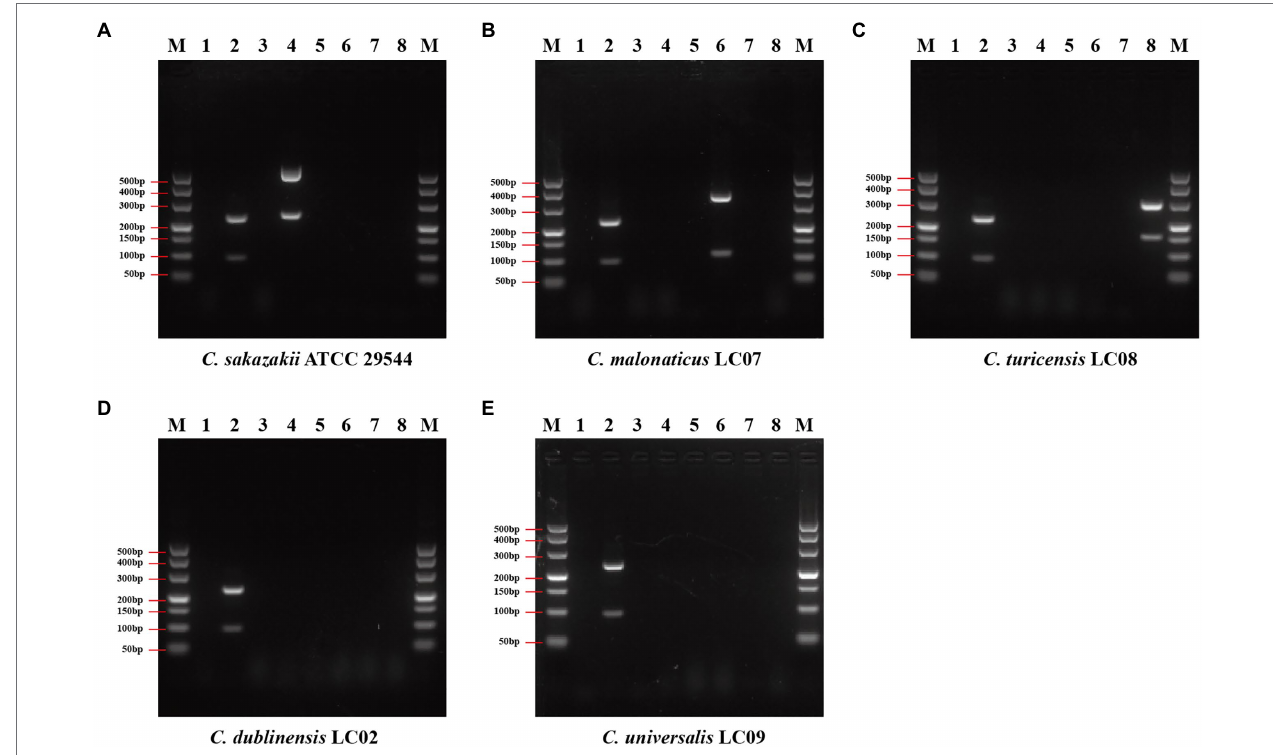
FIGURE 4 | Results of duplex PCR based on genus- and species-specific genes. (A) Cronobacter sakazakii ATCC 29544 ™ , (B) Cronobacter malonaticus LC07, (C) C. turicensis LC08, (D) C. dubliniensis LC02, and (E) Cronobacter universalis LC09. Lane M: DNA marker; lanes 1, 3, 5, and 7: negative control without template; lane 2: Cronobacter genus primer set Cro_set; lane 4: C. sakazakii species primer set Sak_set; lane 6: C. malonaticus species primer set Mal_set; and lane 8: C. turicensis species primer set Tur_set.